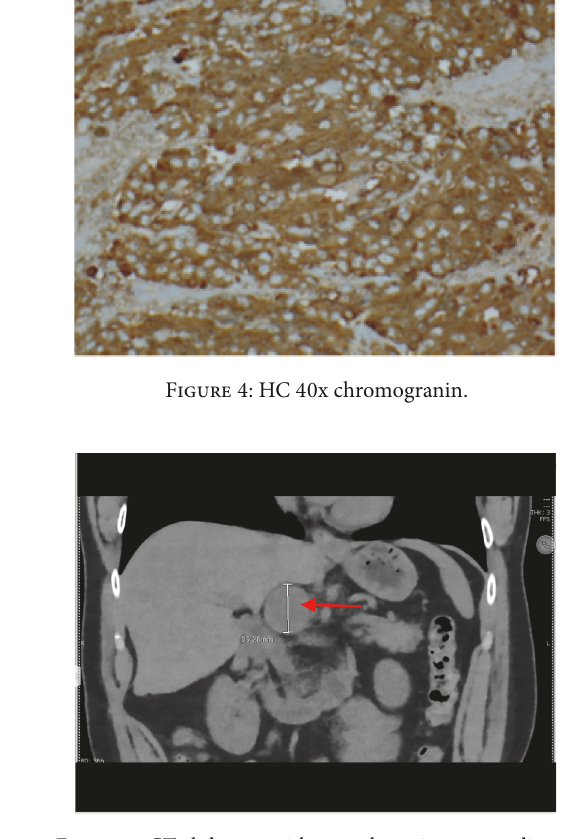
Figure 5: CT abdomen with porta hepatis